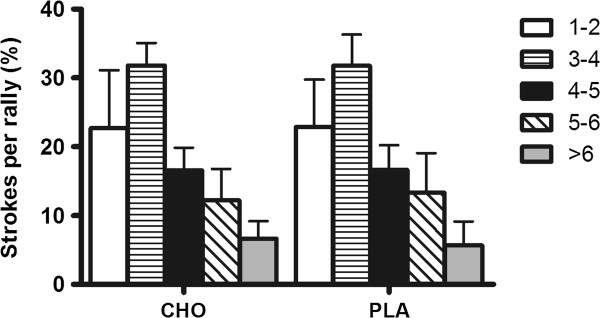
Distribution of strokes per rally (%; mean±SD) during PLA and CHO conditions.